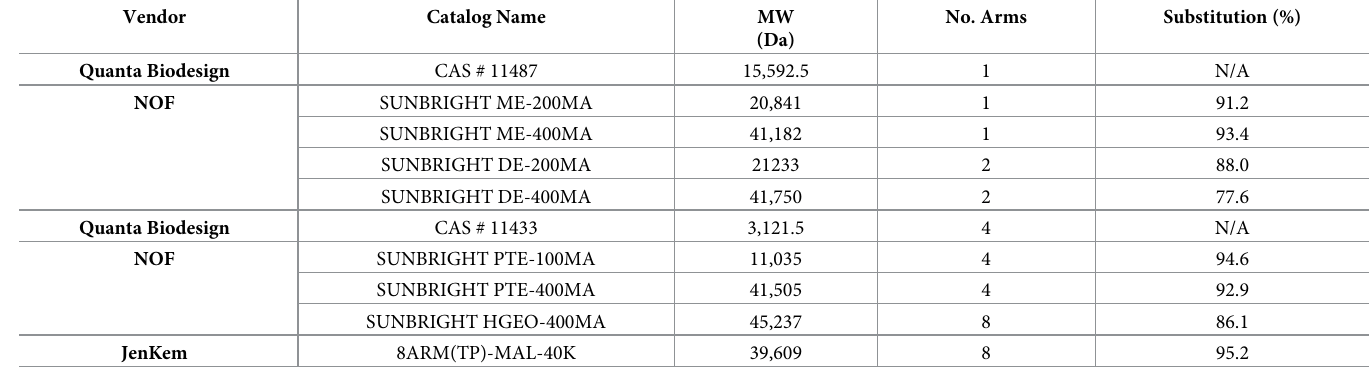
Table 1. List of the ten different PEG compounds that were used to make PEG+Fab conjugates. Specifications were determined by respective vendors. In some cases, substitution was not available as denoted by N/A. Vendor